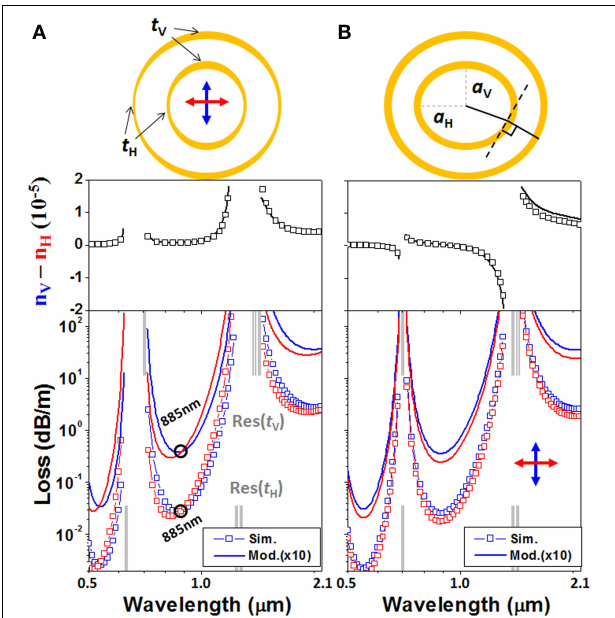
FIGURE 11 | Simulated birefringence and PDL of ARFs composed of 12 FIGURE 10 | Modeled and simulated birefringence and PDL of ARFs capillary tubes. In (A) , an air core with the radius of 15 µ m is surrounded by having H/L/H core-surrounds. In (A) , the glass thicknesses vary from two types of capillaries. The six yellow ones have an outer diameter of 10.2 µ m 0.67 µ m (in the vertical direction) to 0.6 µ m (in the horizontal direction), and a glass thickness of 0.67 µ m. The other six pink capillaries have the same whereas the inner radius (15 µ m) and the outer radius (26.34 µ m) keep outer diameter but a thinner glass thickness (0.6 µ m). In (B) , an elliptical air unchanged. The modeled and simulated zero-PDL wavelengths both appear core (15 µ m 17 µ m) is surrounded by identical capillaries ( d out × at 885nm. In (B) , an elliptical air core (15 µ m 17 µ m) is surrounded by an t 0 . 67 µ m). All the capillaries are untouched with each other, and the × = H/L/H trilayer with t h 0.67 µ m and t l 10 µ m. The black lines in schematic distances between adjacent capillaries are the same. Note that the gray vertical = = define the angular segment employed in the fiber-to-slab geometry lines obtained from Equation (14) define the transmission bands transformation, i.e., the green arrow in Figure 8 .